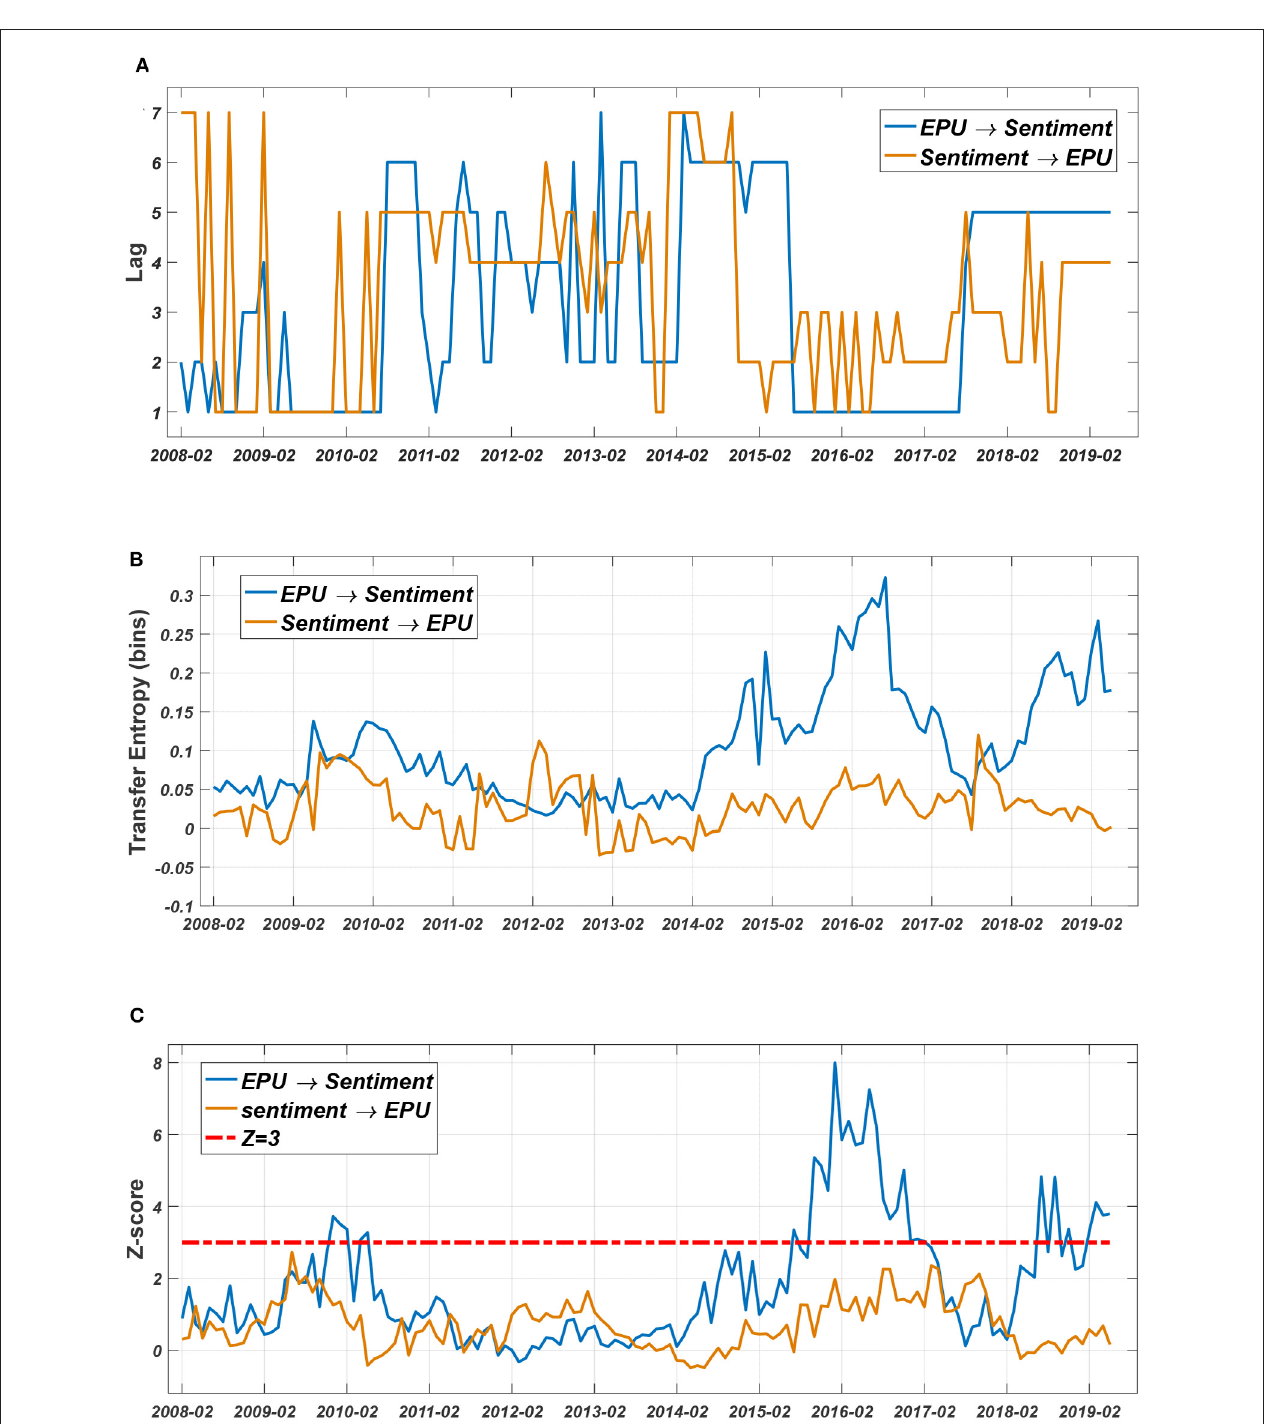
FIGURE 6 | Dynamic Entropy results between EPU and investor sentiment. (A) Lag structure. (B) TE fluctuation. (C) Z -score.